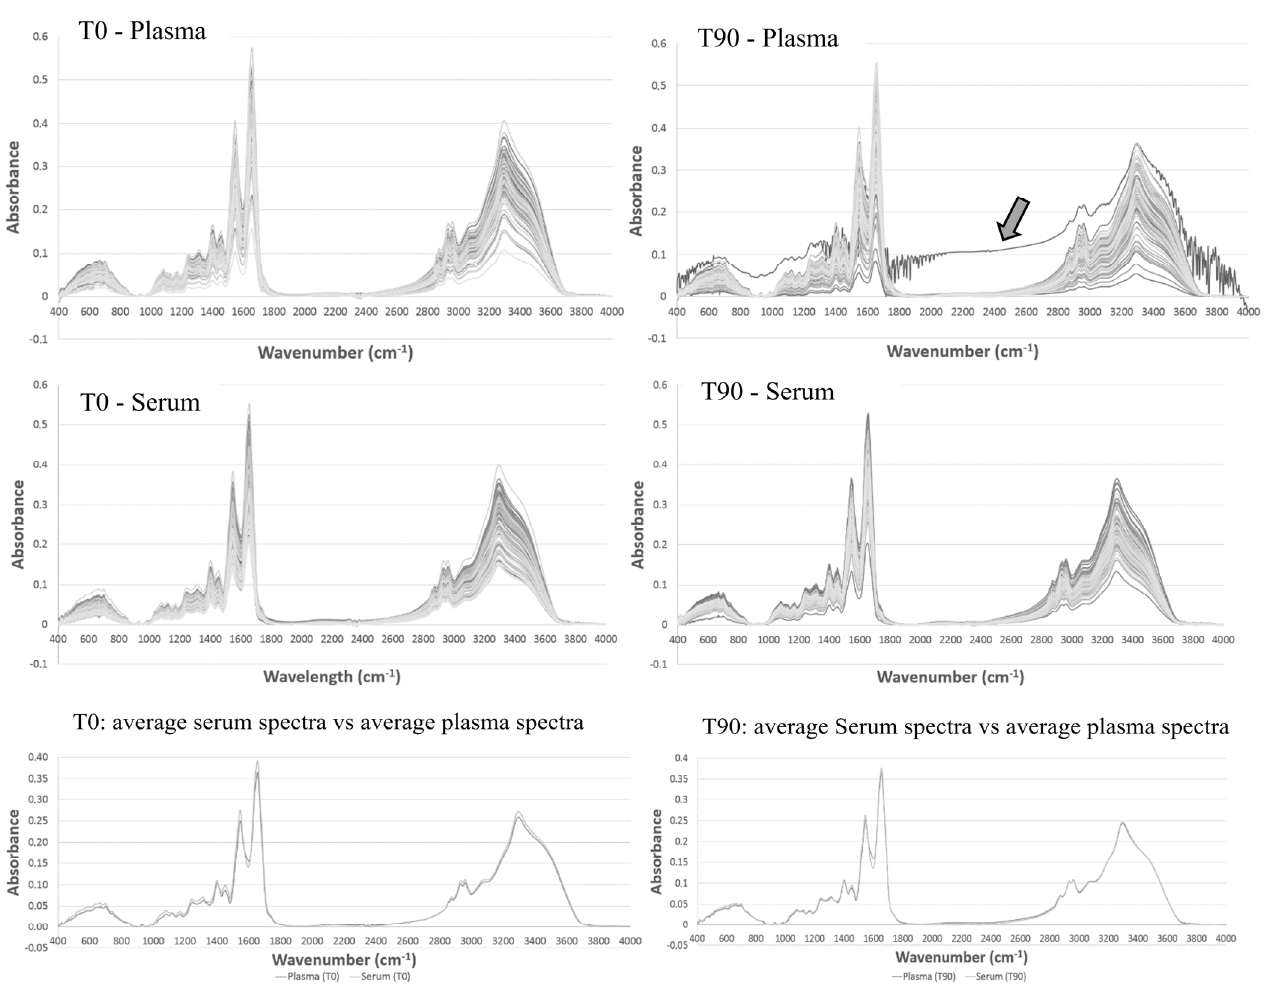
Figure 1. Plasma and serum spectra after atmospheric and baseline correction obtained at T0 and T90, representing all triplicated analysis of the 30 volunteers or in alternative its mean spectra. The arrow indicates the unique spectra eliminated from the subsequent studies.